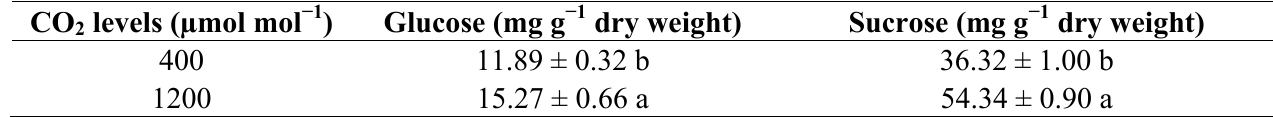
on glucose and sucrose concentration of L. pumila. 2